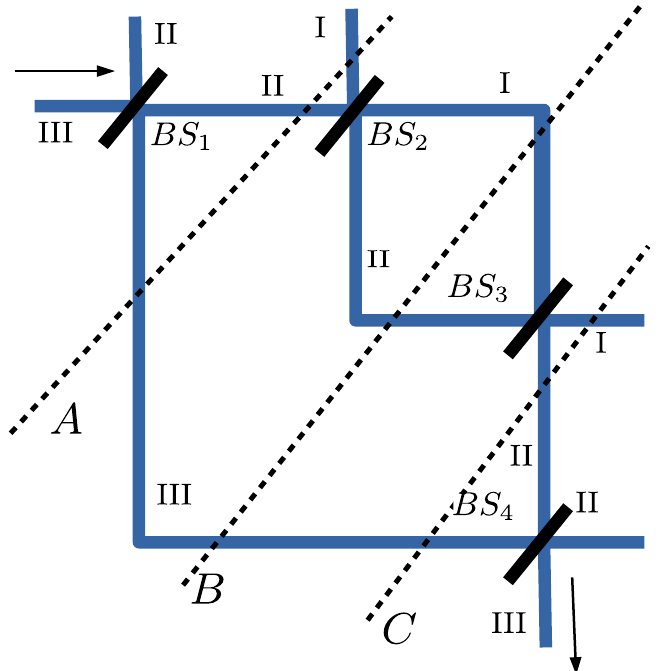
Figure 1. Vaidman interferometer consisting of two Mach–Zehnder nested devices with four beam splitters BS i , i 1, . . . , 4 . Roman numbers I, II, III correspond to vectors in Eq. (1) and A , B , C denote instants where the = weak trace is